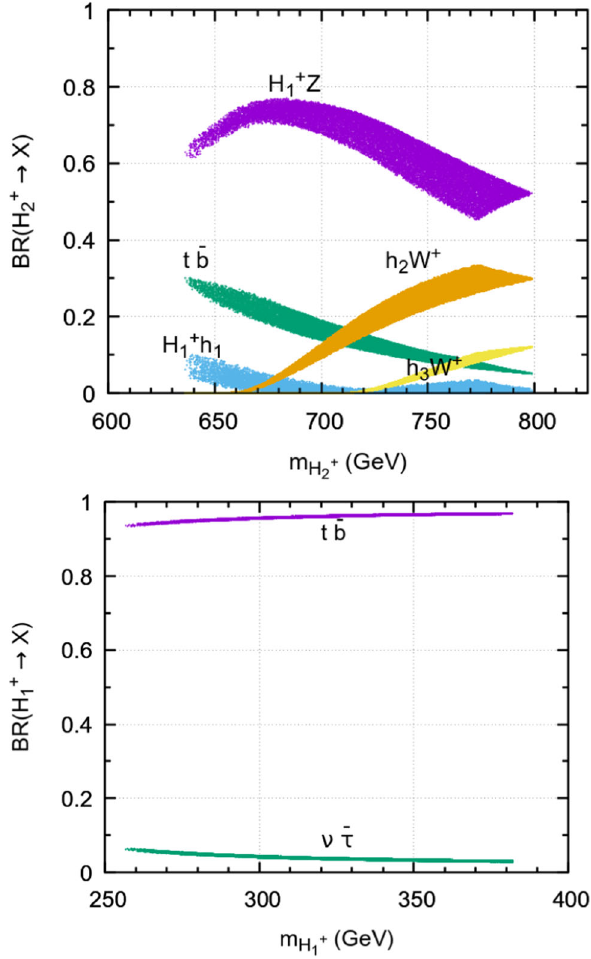
Fig. 10 Dominant BR’s for H + for benchmark point P 1 versus the charged Higgs masses